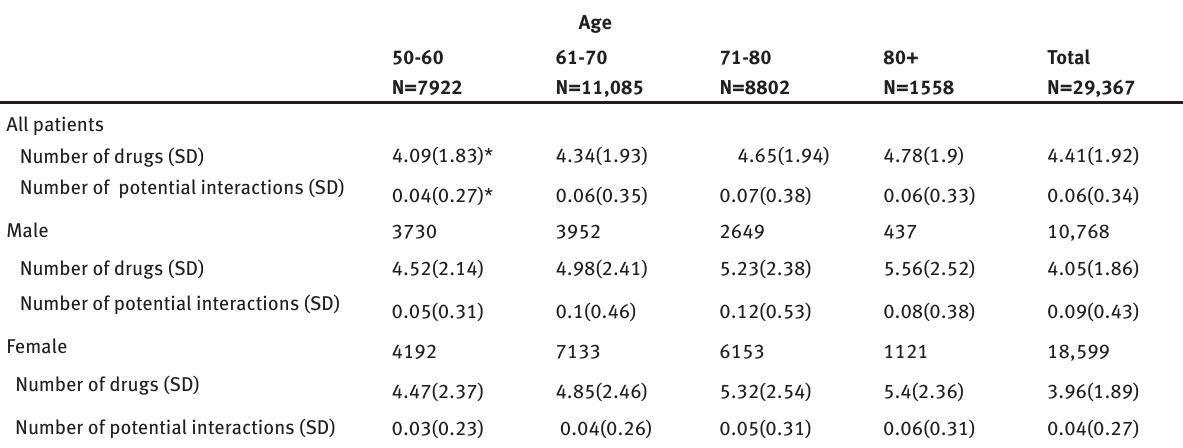
Table 2: Mean number of medicines and potential interactions among statin users by age and